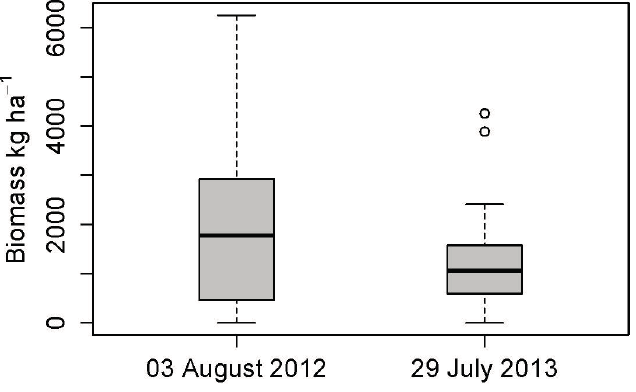
Figure 3. Boxplots showing dwarf shrub biomass amounts of sites located in Hyperion scenes of August 2012 and July 2013, respectively. Each scene contains 30 field